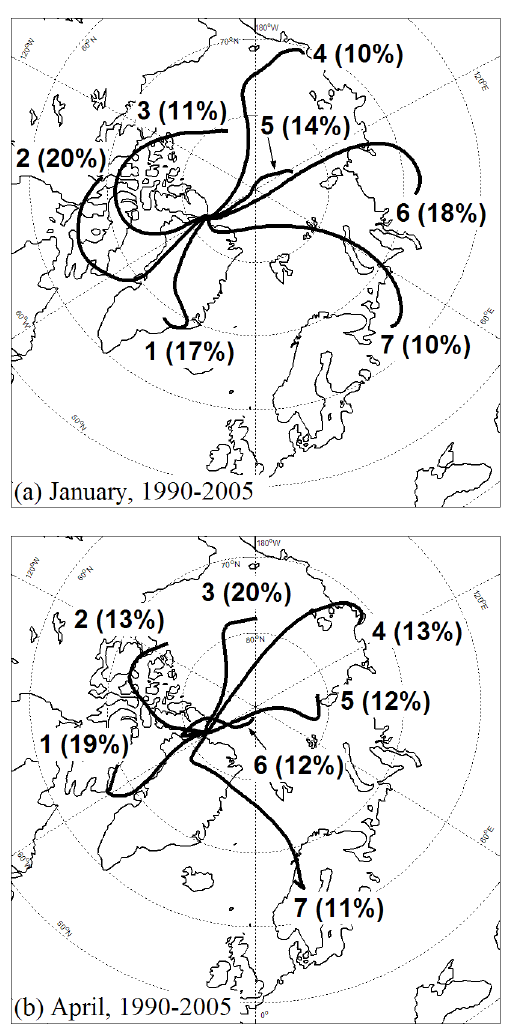
Fig. 2. Transport pathways affecting Alert, Nunavut in January (a) and April (b) from 1990 through 2005 identified by cluster analysis. Each plotted pathway shows the average of 10-day back trajectories generated by the HYSPLIT model. The number outside the brack- ets serves only as an identification of each cluster; the one inside the brackets gives the frequency of occurrence of the underlining transport